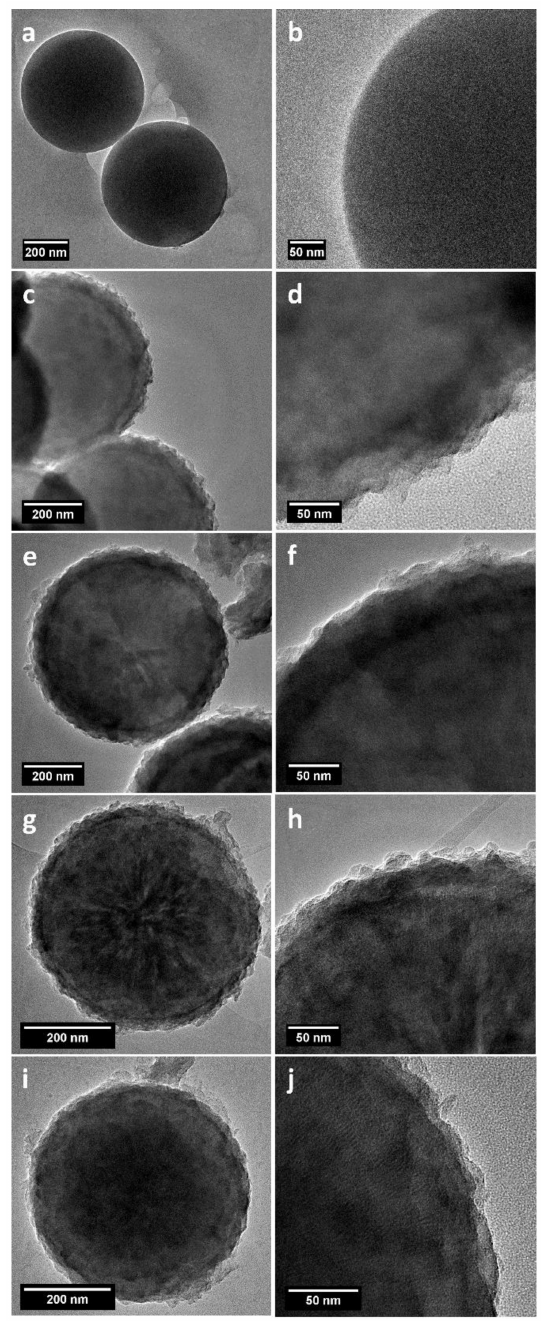
Figure 3. TEM images of silica template ( a , b ) and carbon spheres after 1 h ( c , d ), 2h ( e , f ), 3 h ( g , h ), and 4 h ( i , j ) of